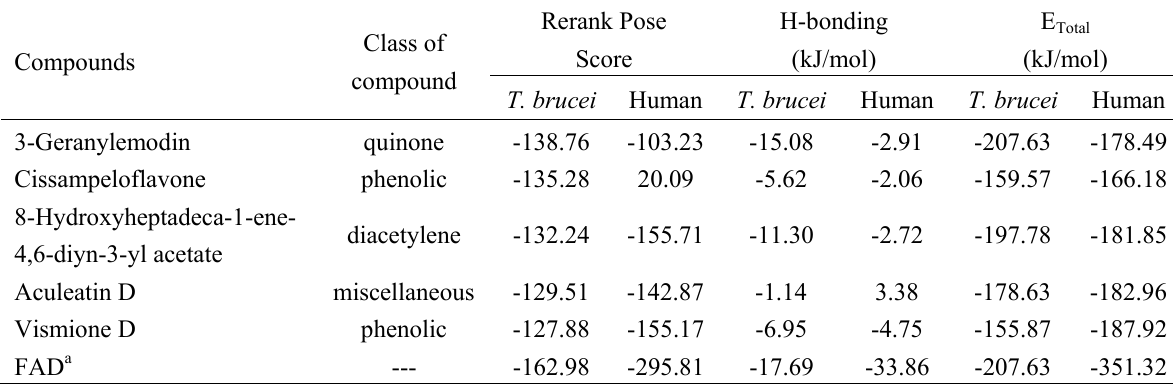
Table 4. Top hit compounds for docking to trypanothione reductase (TR) and corresponding values for human glutathione reductase.